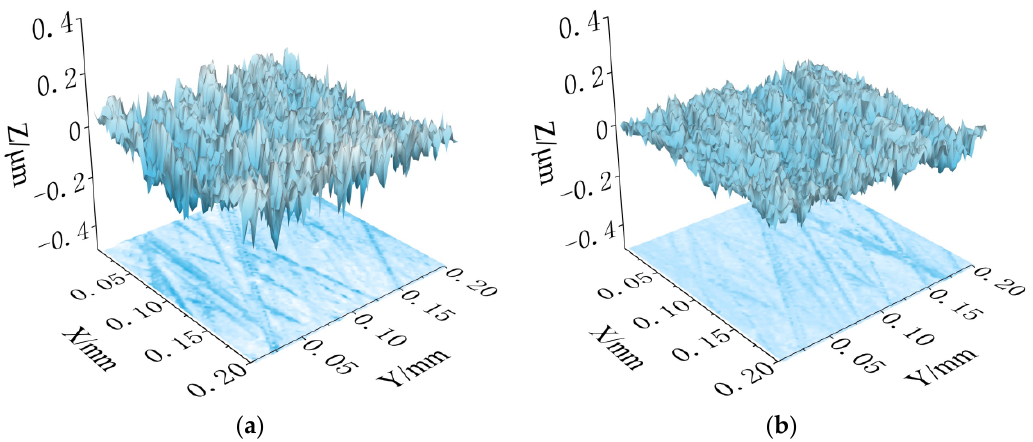
Figure 11. ( a ) Surface morphology before optimization, ( b ) surface morphology after optimization.